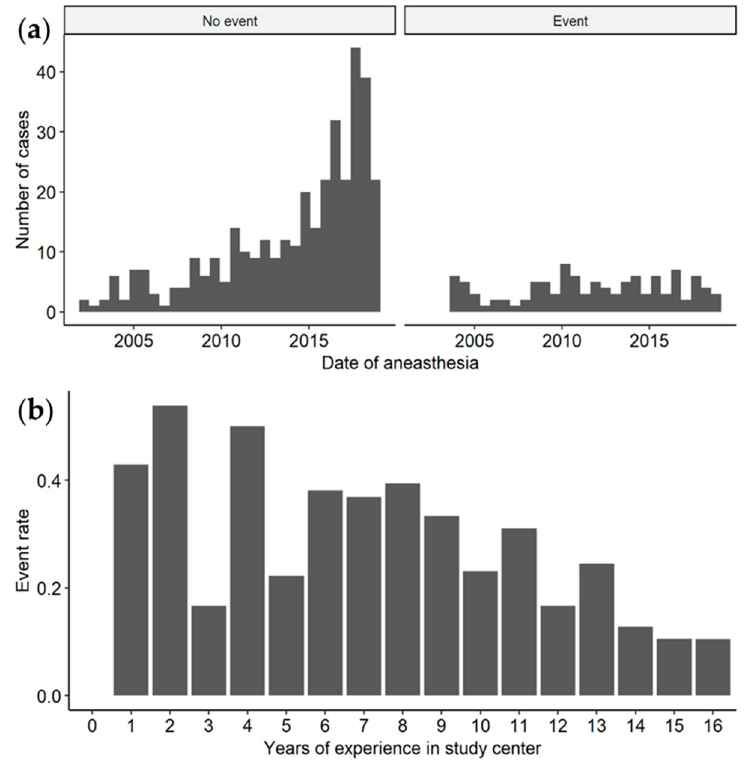
Figure 2 . Centre experience. ( a ) Cases with and without events performed during the study period. ( b ) Event rates in different study intervals, calculated in years after inclusion of the first study patient.